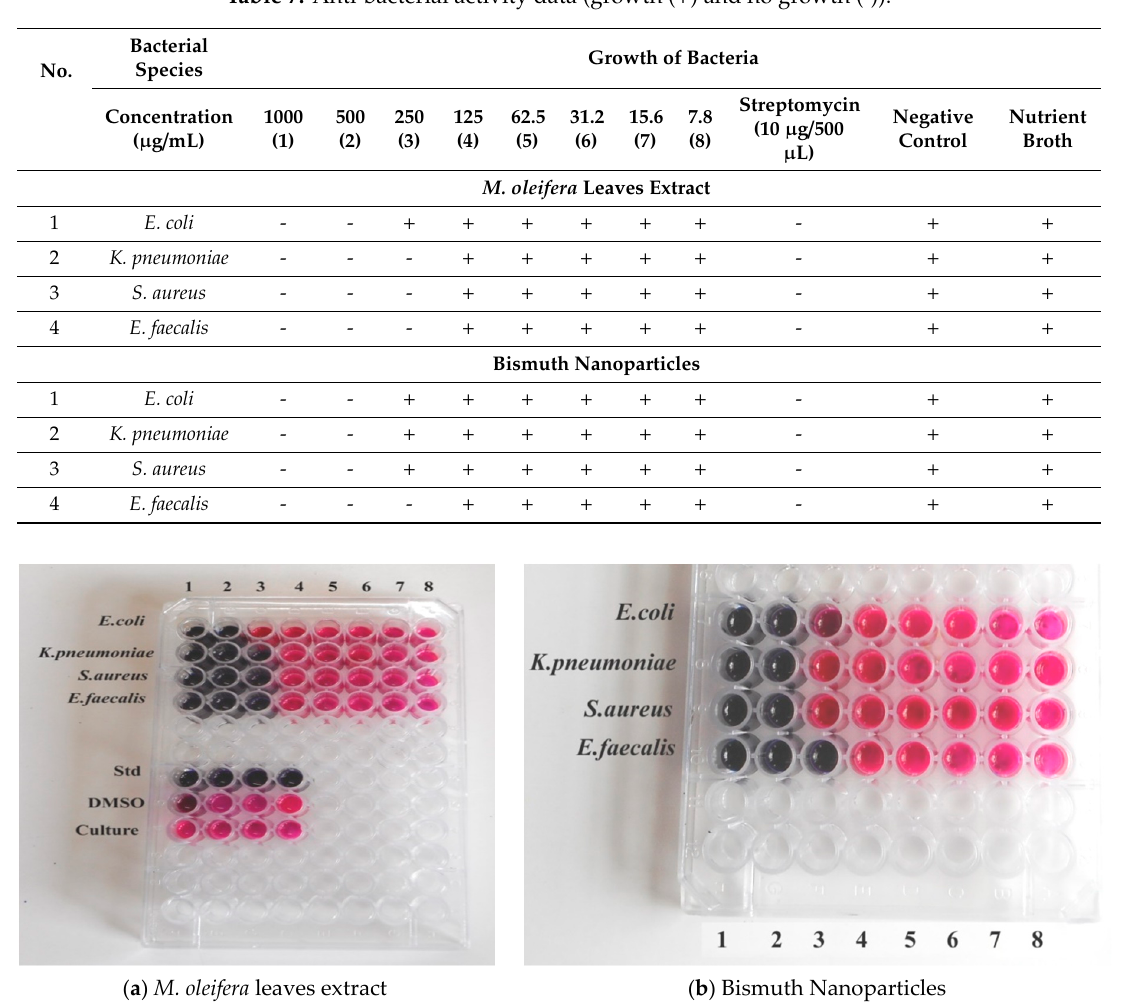
Table 7. Anti-bacterial activity data (growth ( + ) and no growth (-)).